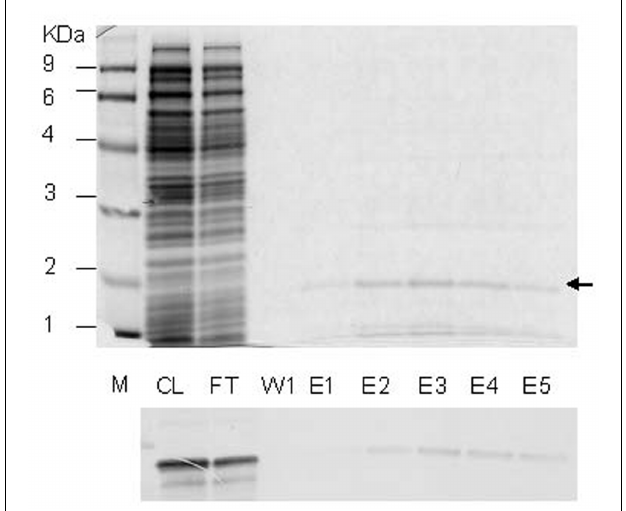
FIGUREA1 | Purification of PLAFP. (Top) SDS-PAGE gel for different fractions of purification of PLAFP-His. M, molecular weight marker; CL, cleared lysate; FT, flow-through;W1, wash fraction; E1–E6, elution fractions. (Bottom)Western blot analysis for the above listed factions using Anti-His antibody to visualize